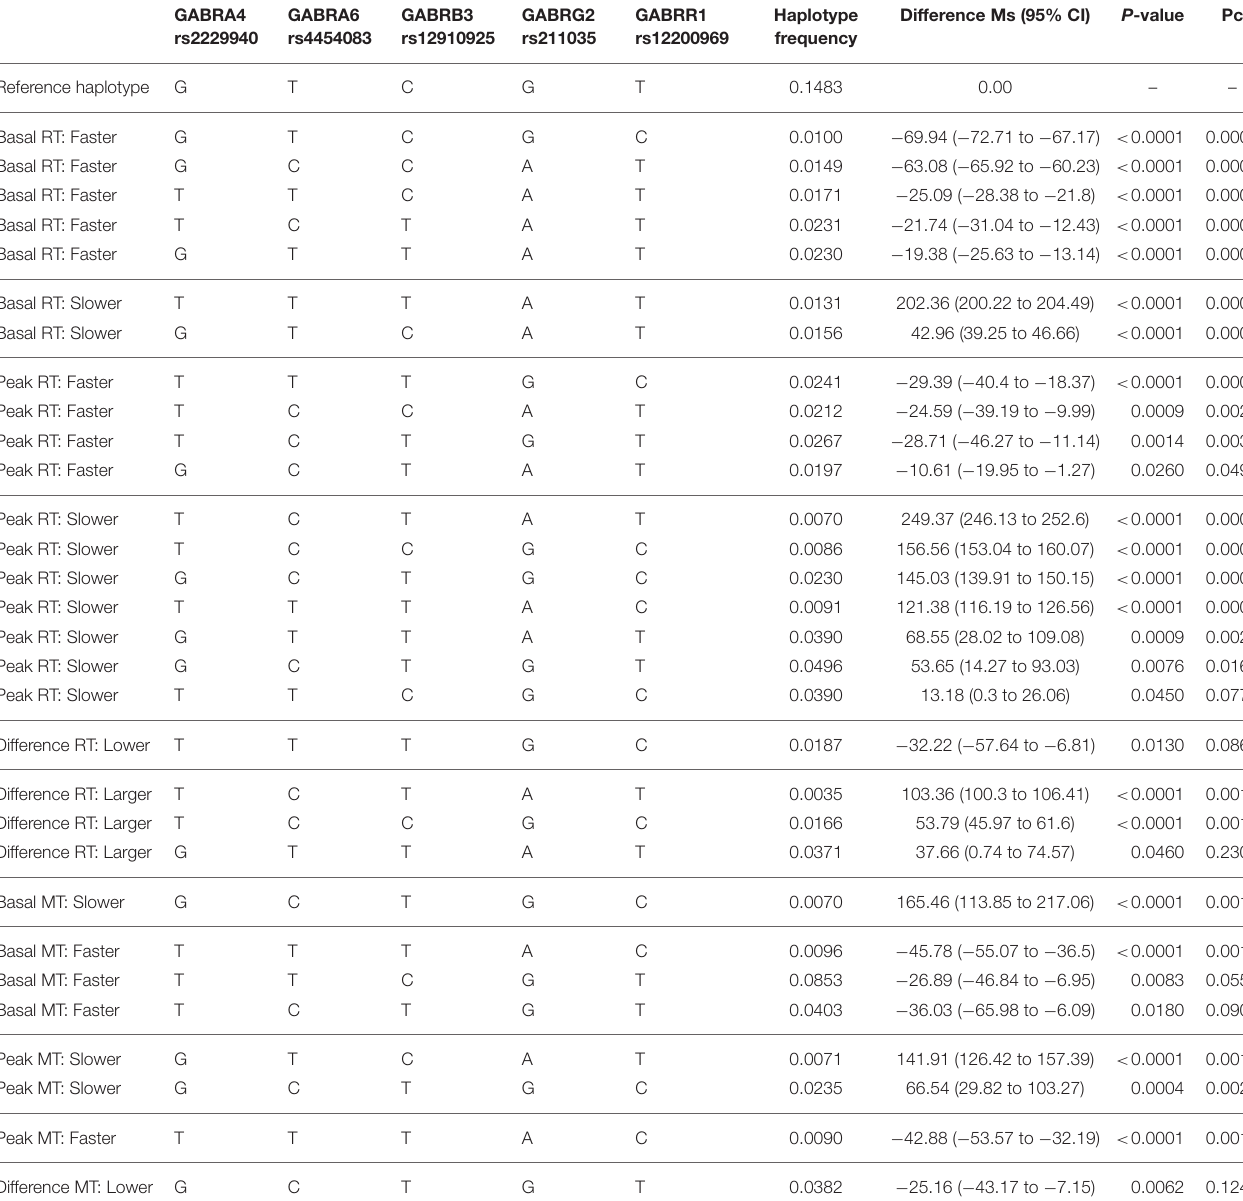
TABLE 6 | Statistically significant interactions of selected GABR haplotypes with reaction and motor